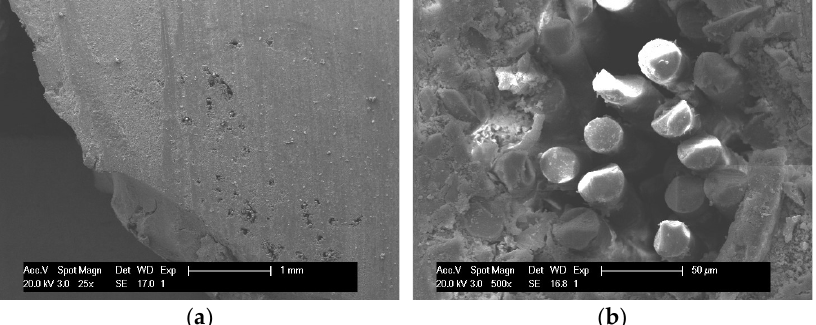
Figure 14. The microstructure of G2 after accelerated aging at 60 °C for 180 days: ( a ) 25 × G2; ( b ) 500 × G2.